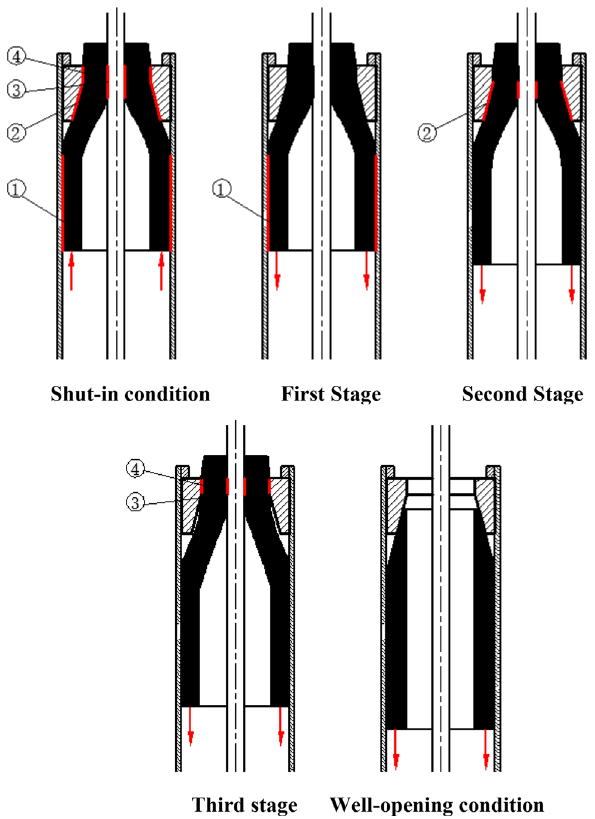
Fig. 11 Unsealing process of rubber